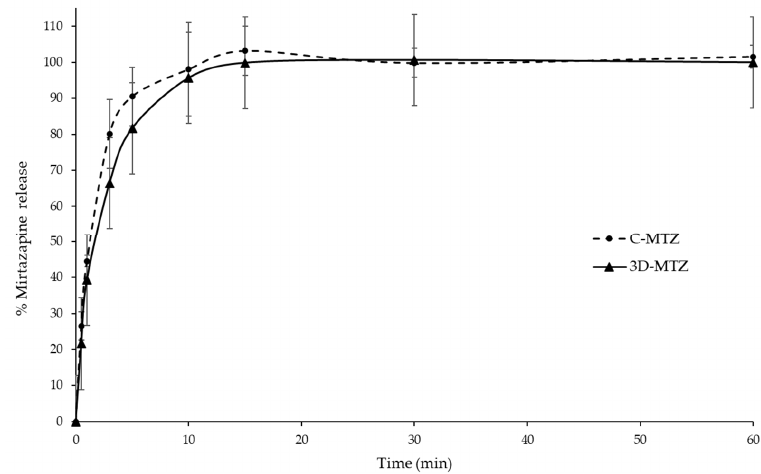
Figure 6. The release profile of MTZ from ODFs in 1 N